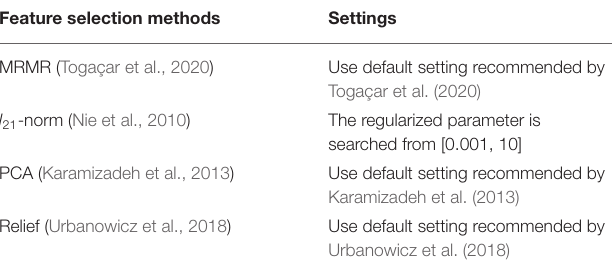
TABLE 1 | Settings of feature selection methods.